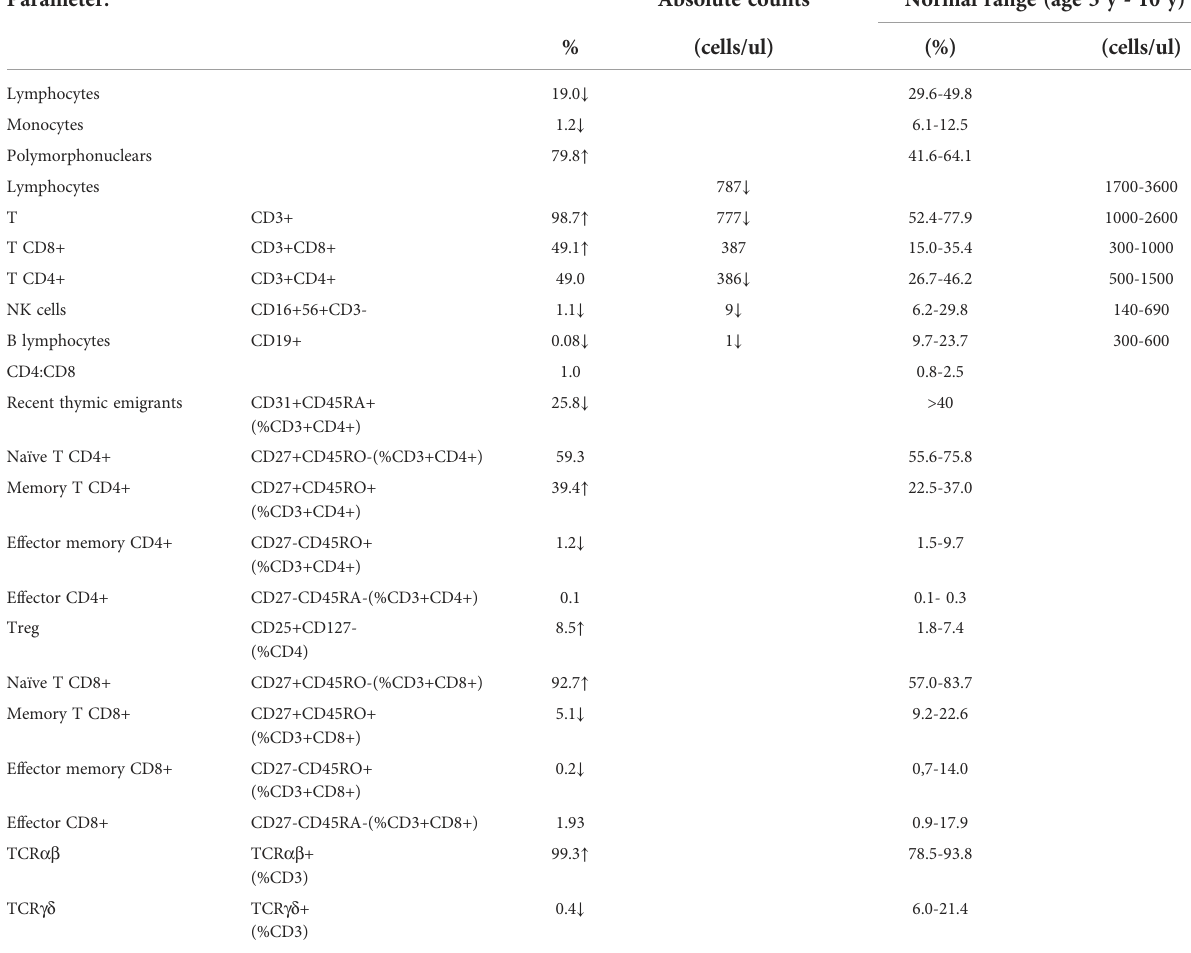
TABLE 1 Results of peripheral blood lymphocyte